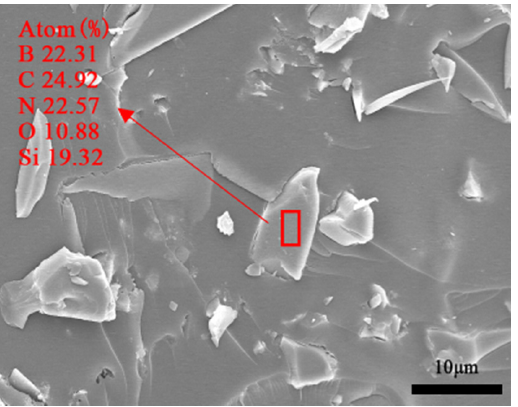
Figure 4. SEM image of the SiBCN phenolic resins after pyrolyzed 2 h at 1200 °C in Ar atmosphere.